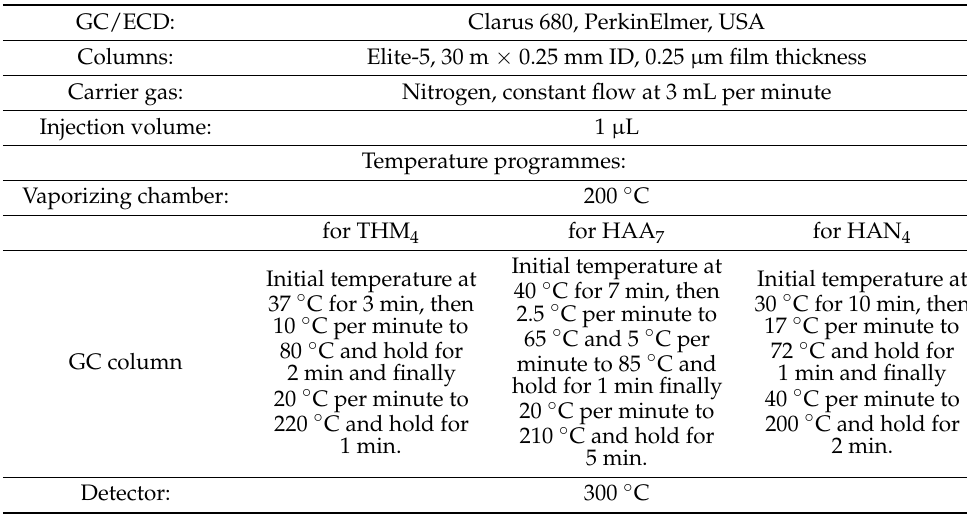
Table 2. Analytical methods and conditions for DBP